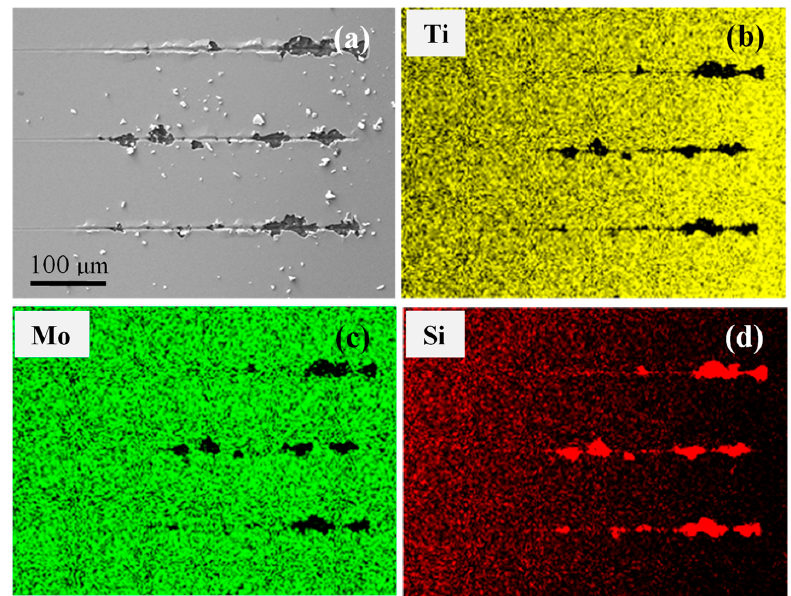
Figure 6. (Color online) ( a ) A magnified SEM image of three scratch tracks on the Mo-8 sample and the ( b ) Ti, ( c ) Mo, and ( d ) Si element distributions of